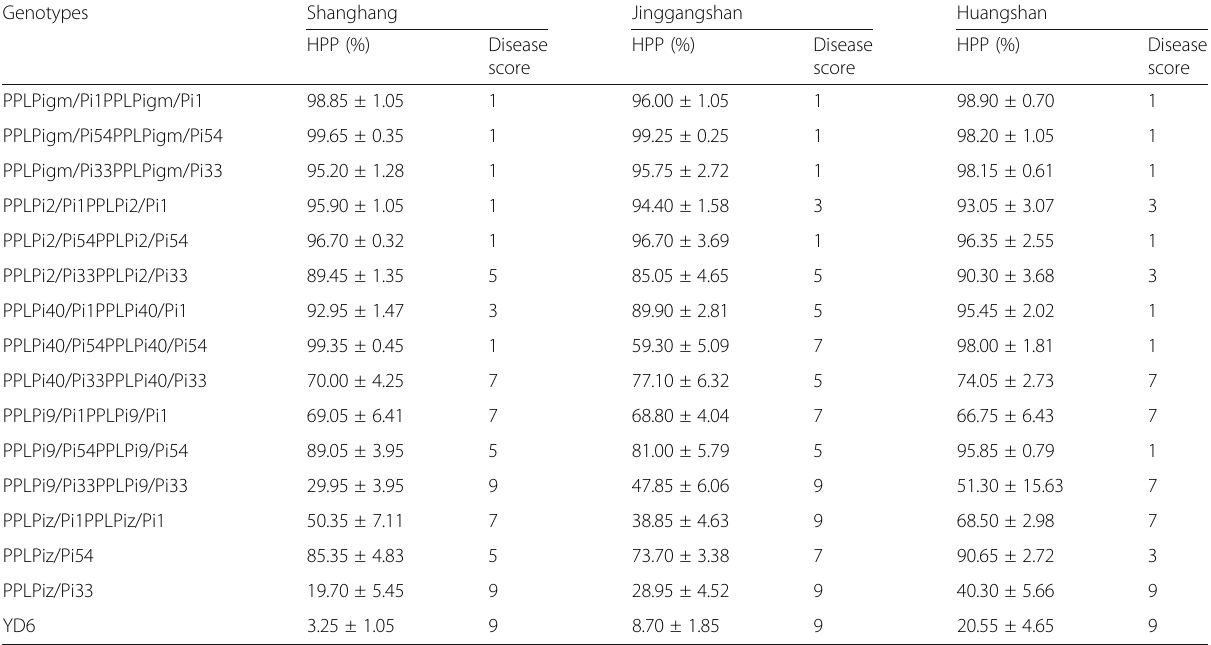
Table 1 Resistant performance of panicle blast for PPLs and the recurrent parent at three hotspot locations during the summer season in 2017 Genotypes Shanghang